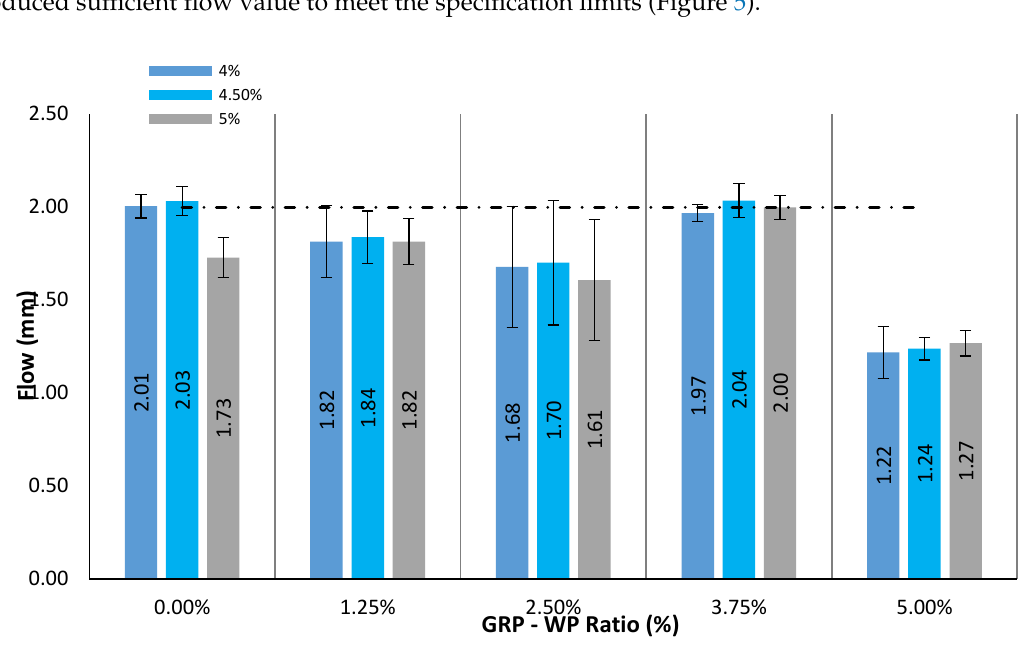
Figure 5. Comparison of flow results for the 45 samples tested.